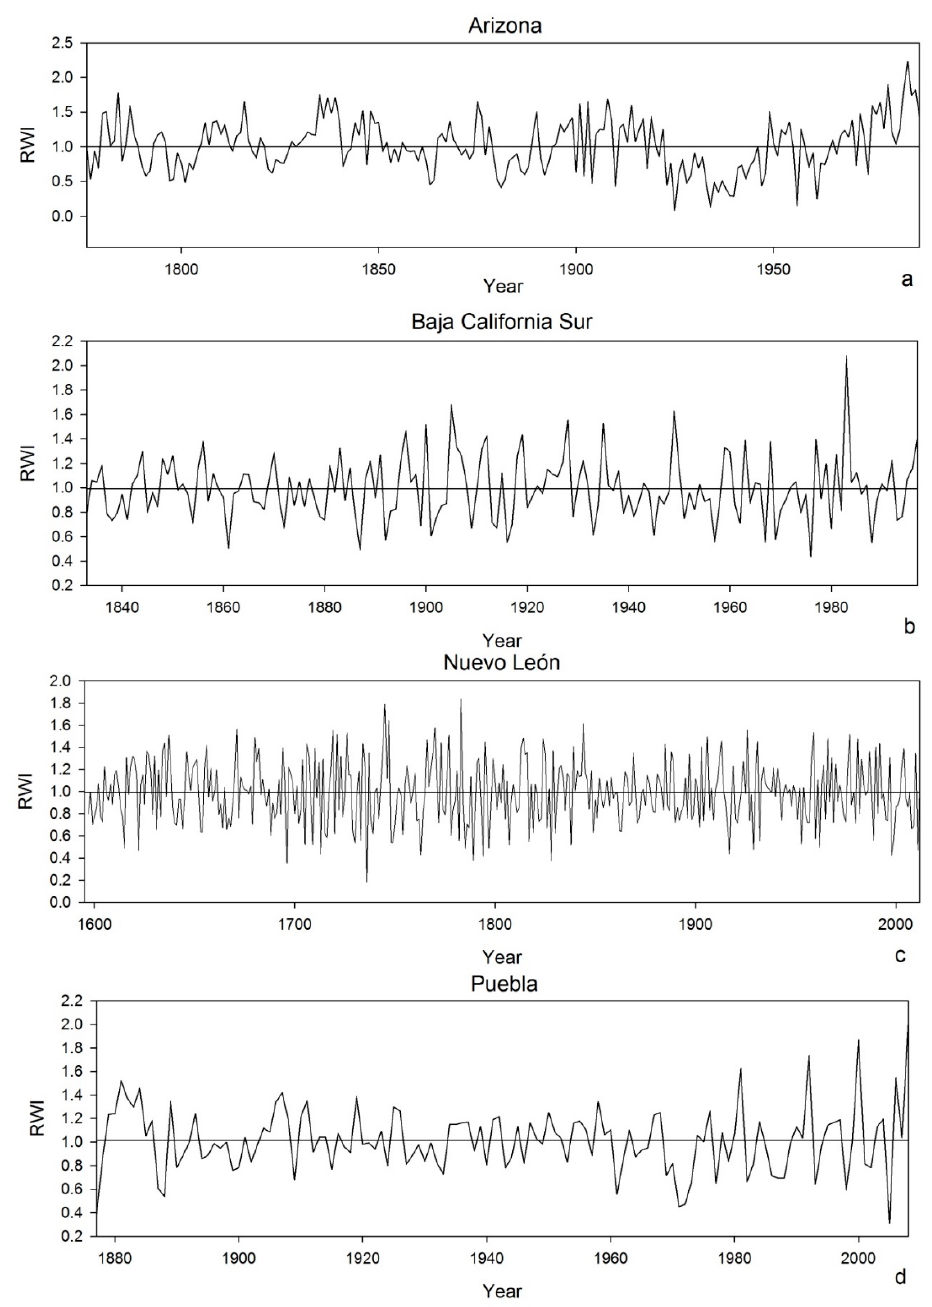
Figure 2. Residual chronologies of ring-width indices (RWI) of ( a ) Arizona; ( b ) Baja California Sur; ( c ) Nuevo León; and ( d ) Puebla. The residual chronology of Arizona was directly retrieved from the ITRDB.